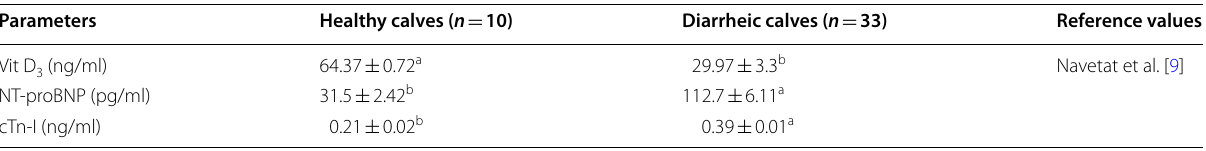
The data are presented as mean a,b Means within the same column with different superscripts differ significantly ( P <